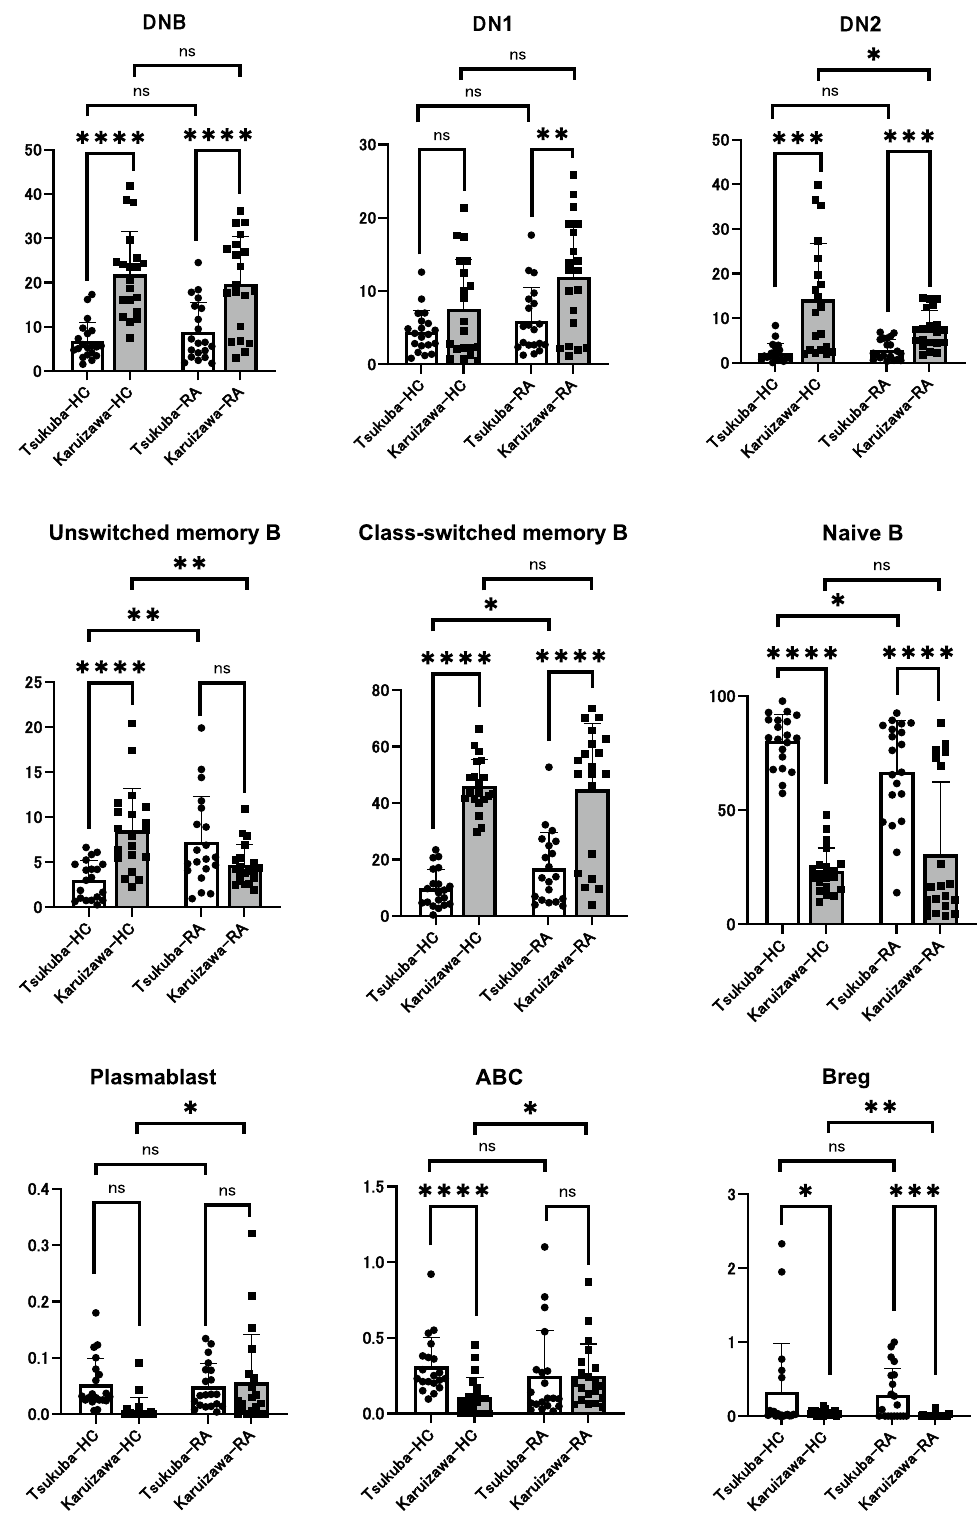
Figure 2. Differences in the proportion of subpopulations of peripheral blood B cells between RA patients and HCs from two distinct geographic locations. The proportion of subpopulation in B cells in PBMC collected from RA patients and HC in two hospitals was analyzed by flow cytometry. Histograms show percentage of class switched memory B cells, unswitched memory B cells, memory B cells, and double negative (DN) B cells in CD19 + CD20 + cells, DN1 cells and DN2 cells in DNB cells, plasmablast in CD19 + CD20 − cells, ABC and Breg cells in CD19 + cells. Data are presented as mean ± SEM. Unpaired t-test was performed to analyze a statistical interaction between blood samples collected from HC or RA patients in Tsukuba or Karuizawa. Statistical significance was defined as * P < 0.05, ** P < 0.01, *** P < 0.001, and **** P <